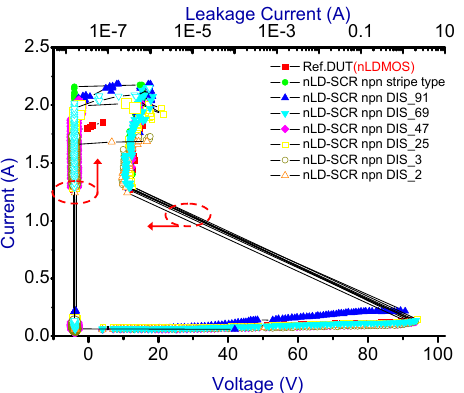
Figure 5. Snapback current-voltage curves and leakage currents of nLDMOS-SCR ( n-p-n -arranged) tested samples.